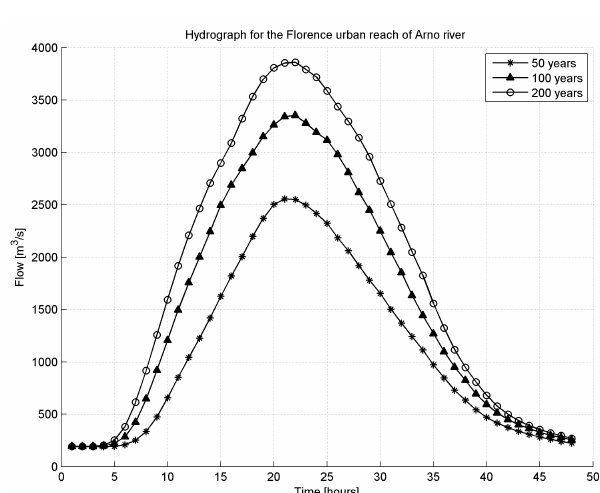
Fig. 4. Hydrographs for the upstream reach of the city of Florence Figure 4. Hydrographs for the upstream reach of the city of Florence for different return 2 for different return periods. 3